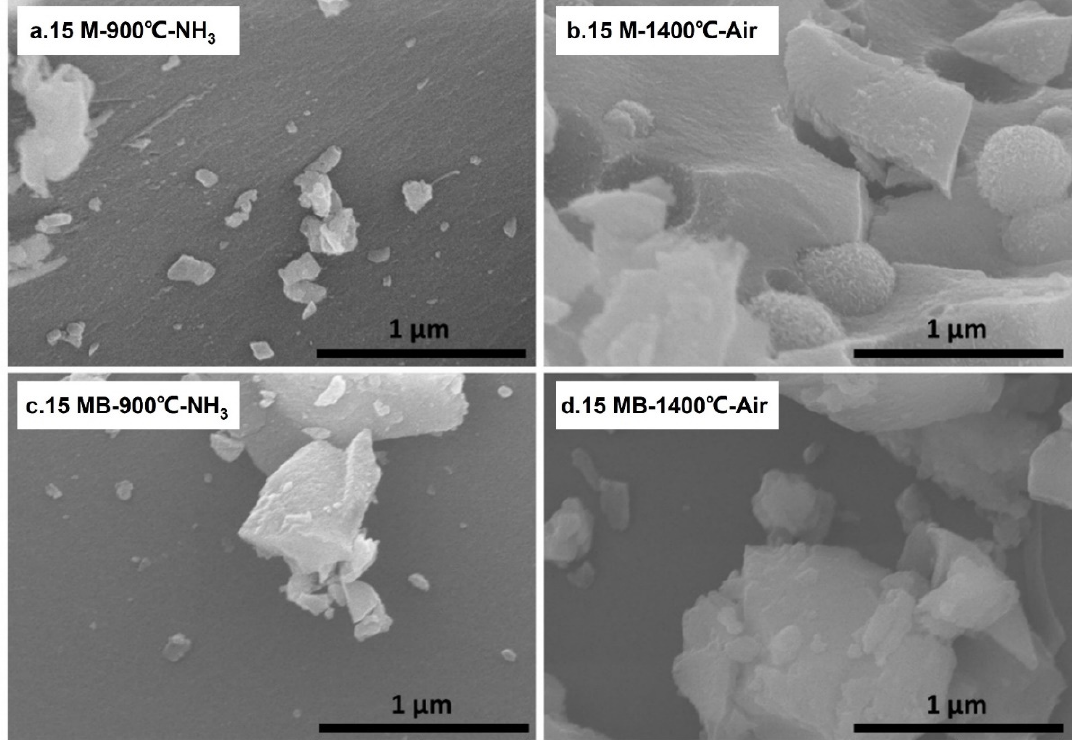
Figure 14. SEM diagrams of the air oxidation products of the two precursors (15 M ( a , b ) and 15 MB ( c , d )).